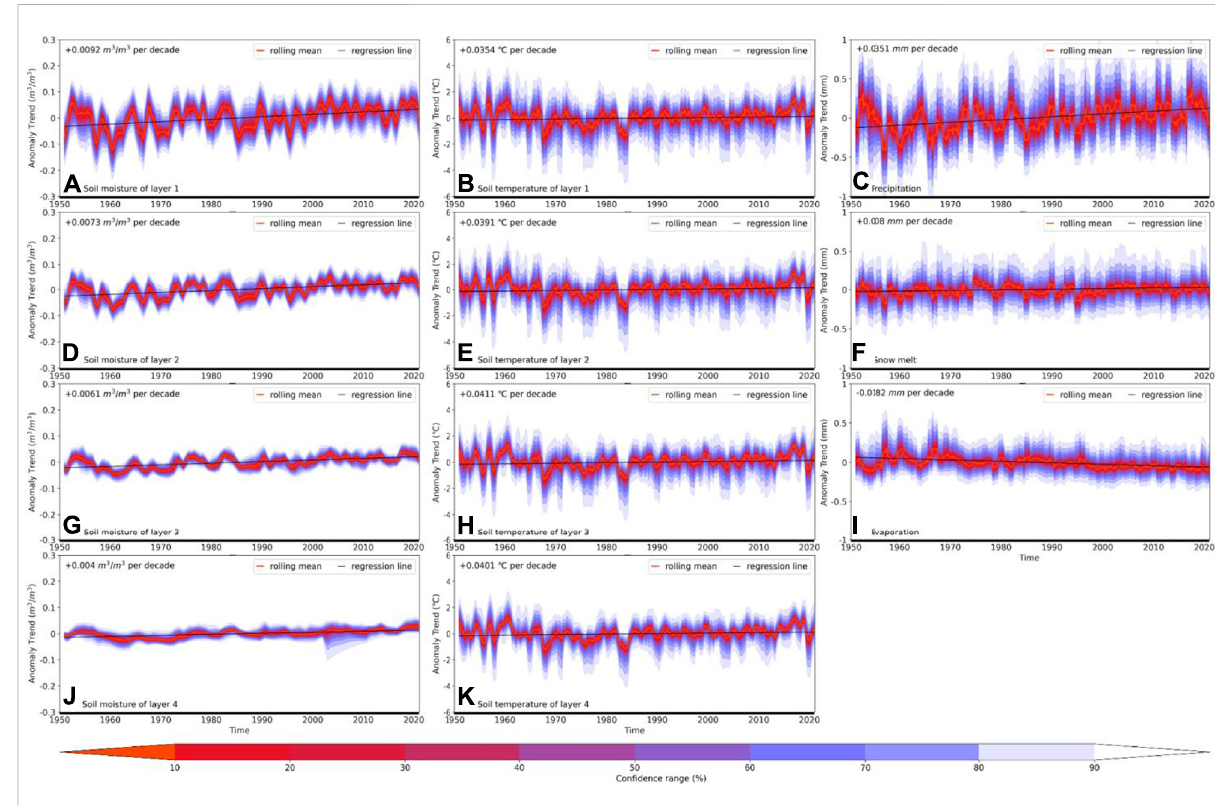
FIGURE 8 Time series of the evolutionary anomaly trends of soil moisture (A , D , G , J) , soil temperature (B , E , H , K) , precipitation (C) , snowmelt (F) , and evaporation (I) at the wetting region with con fi dence ranges and regression